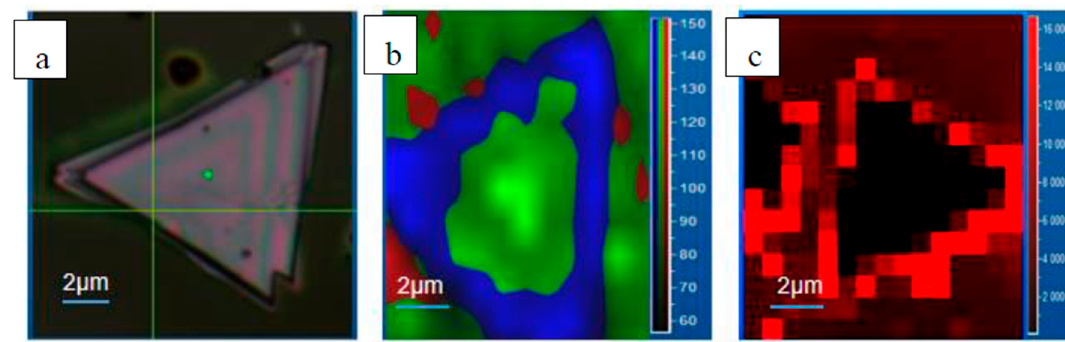
Figure 4. ( a ) SnSe 0.93 S 0.94 light microscopy image. ( b ) Raman spectral intensity mapping for the A 1g mode (green) of SnSe 2 , and the A 1g mode (blue) of SnS 2 for SnSe 0.93 S 0.94 nanosheets. ( c ) The 2D SERS mapping of S-doped SnSe 2 nanosheet.